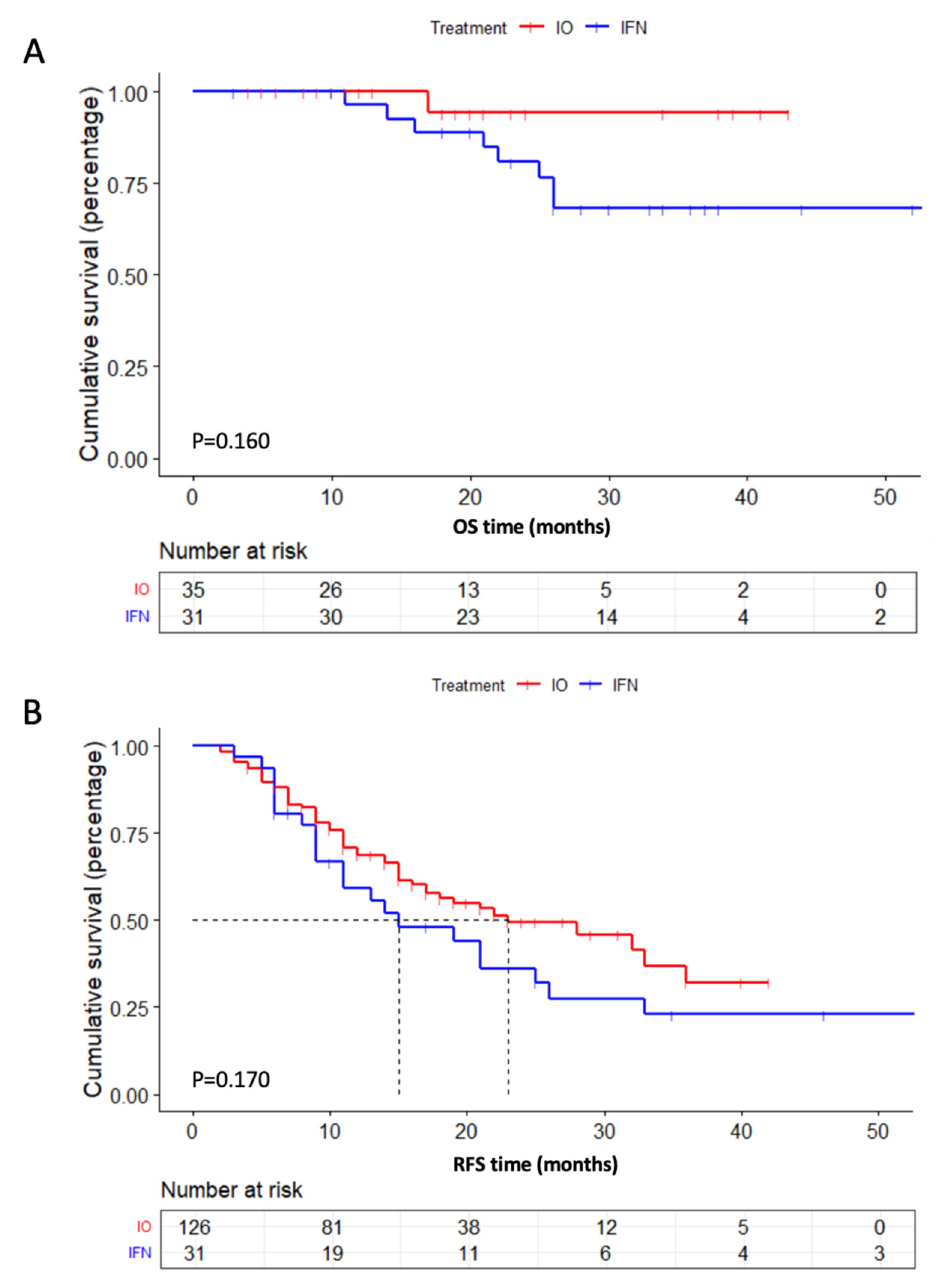
Figure 2. Kaplan–Meier curves of OS ( A ) and RFS ( B ) for all enrolled acral and cutaneous patients stratified by adjuvant PD-1 inhibitor treatment versus IFN treatment.